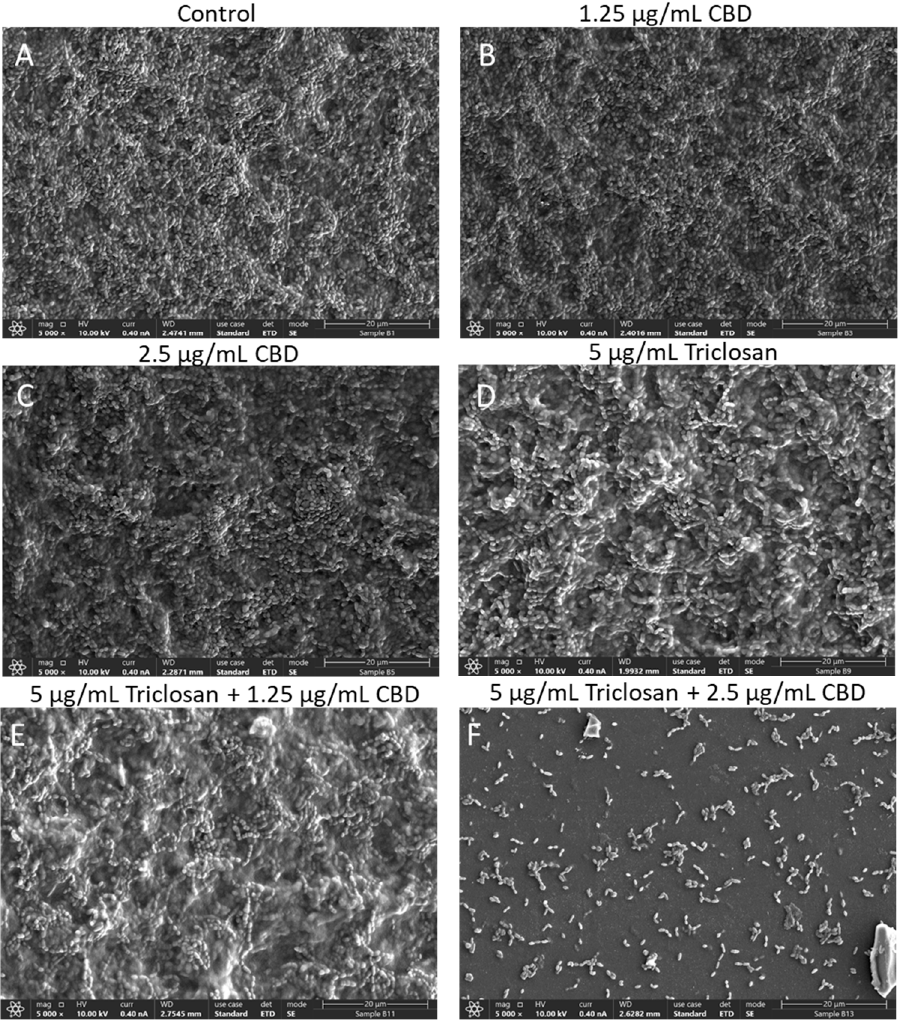
Figure 8. High-resolution scanning electron microscope (HR-SEM) images of S. mutans biofilms formed after a 24 h treatment with the indicated treatments. A. Biofilm of control sample after a 24 h incubation in BHIS. B – E. Biofilms formed in the presence of 1.25 μ g/mL CBD ( B ), 2.5 μ g/mL CBD ( C ), 2.5 μ g/mL triclosan ( D ), 2.5 μ g/mL triclosan with 1.25 μ g/mL CBD ( E ) or 2.5 μ g/mL triclosan